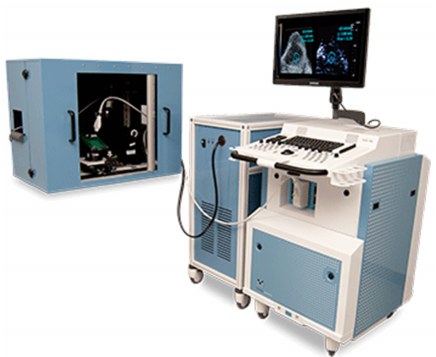
Figure 2. Commercial multispectral photoacoustic system: Vevo